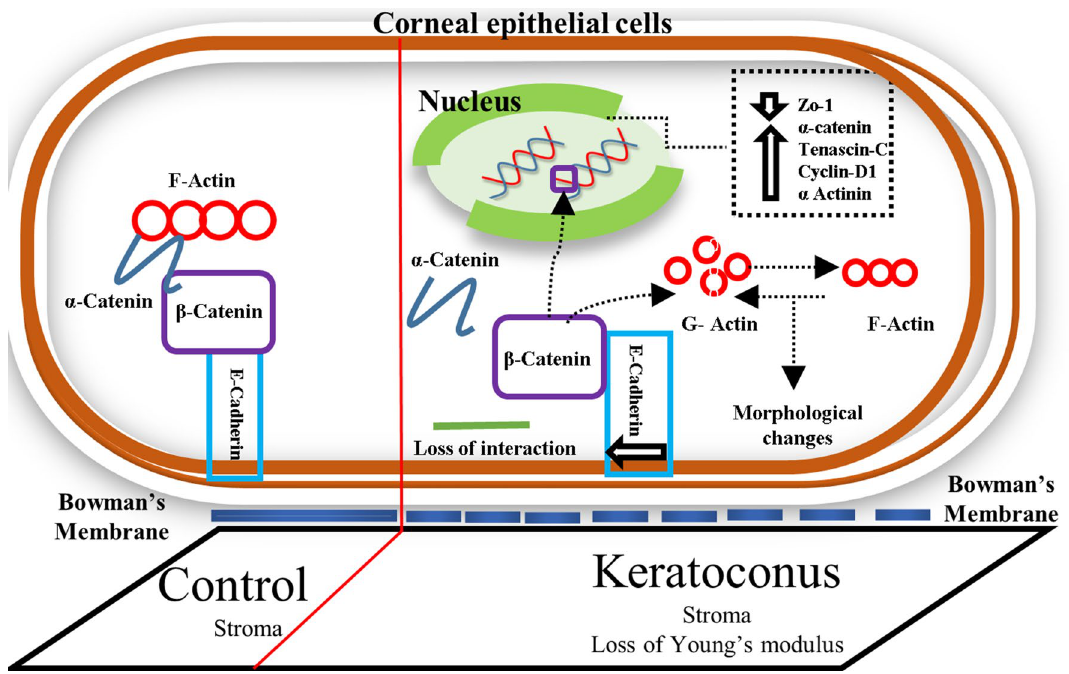
Figure 7. Pictorial representation of β-catenin dependent mechanotranduction in corneal